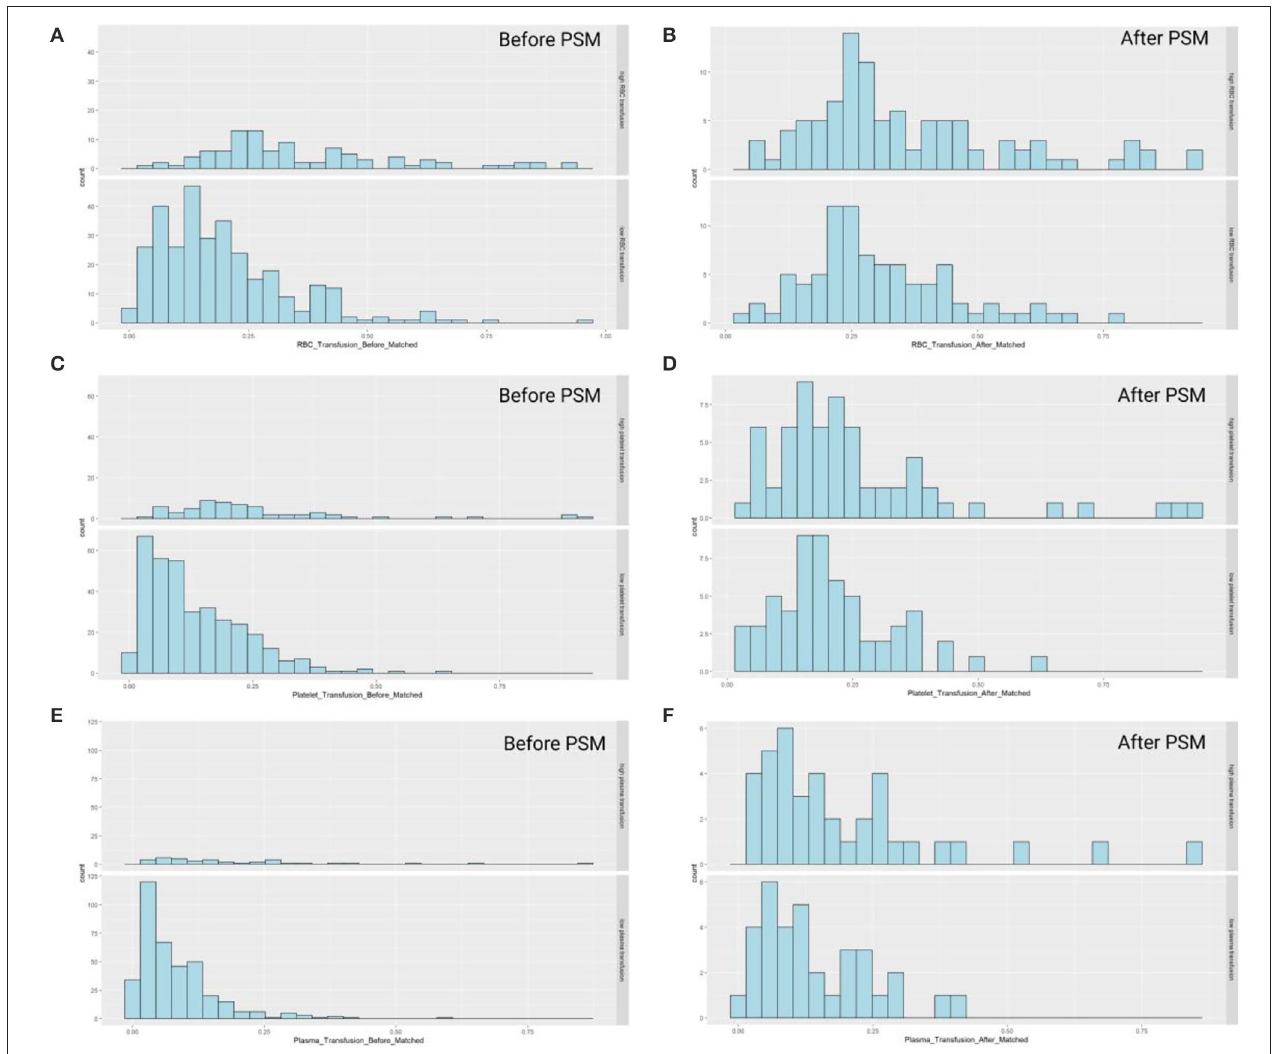
FIGURE 3 | The scores of three components presented skewed distribution prior to the propensity score matching, and approximately normally distributed after match. The score distributions were separately shown as below, in which the study population was divided into two groups based on the transfusion amount of: (A) red blood cell (before matching); (B) red blood cell (after matching); (C) platelet (before matching); (D) platelet (after matching); (E) plasma (before matching); (F) plasma (after matching).